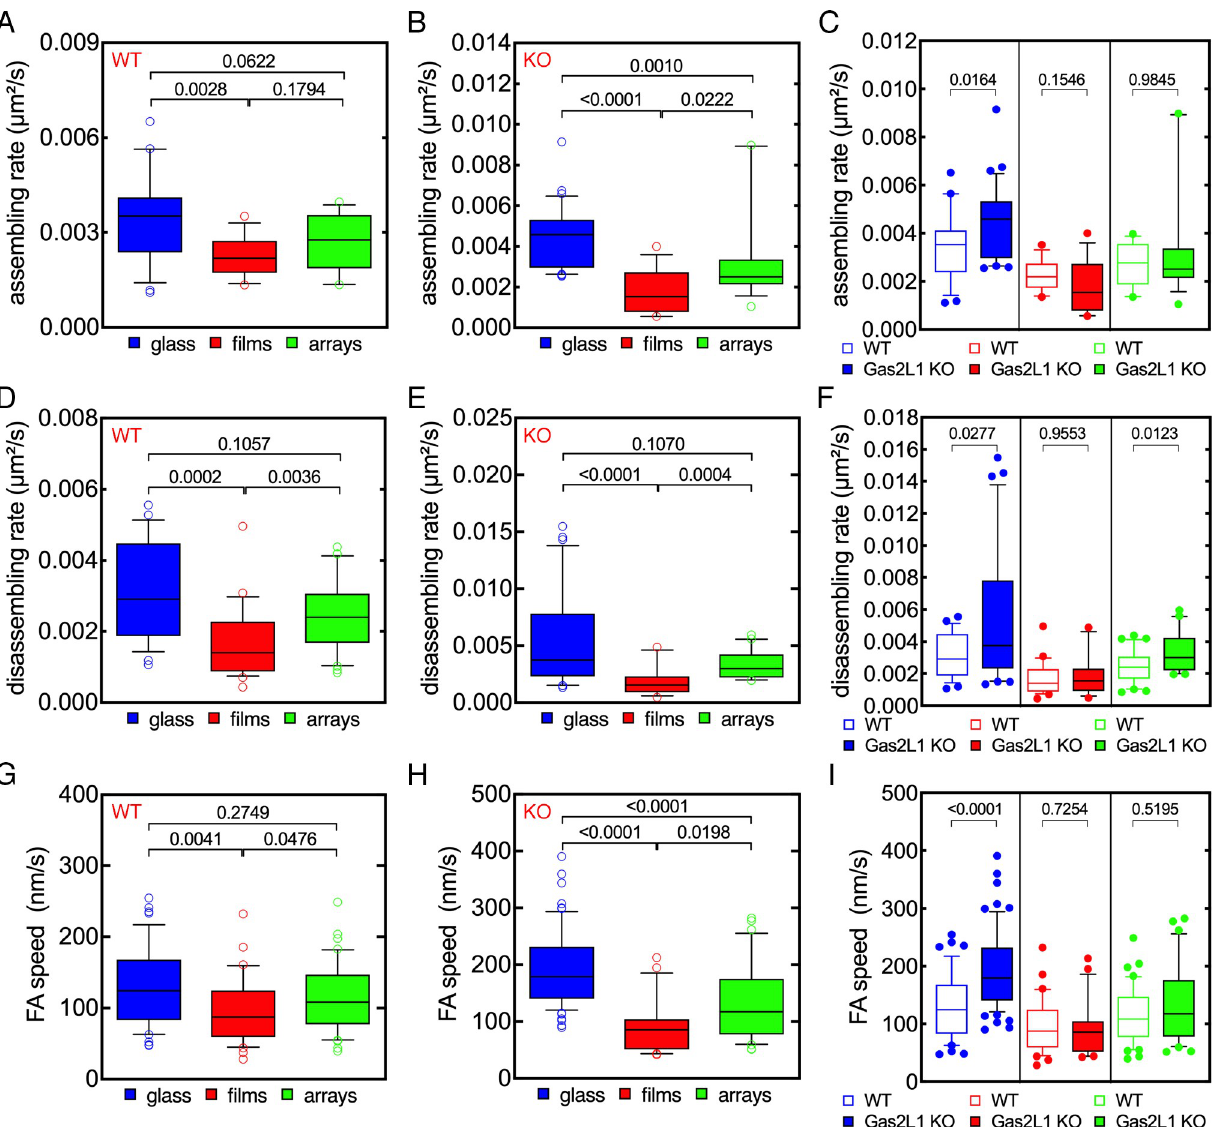
Fig 6. Impact of microgels on focal adhesion dynamics in wild-type and Gas2L1 KO Sertoli cells. (A-C) Control and Gas2L1 KO cells show similar FA assembly rates on microgel films and arrays. In both control (A) and Gas2L1 KO (B) cells, FA assembly rate is higher in cells seeded on to glass and lower in cells on microgel films (A, B). Pairwise comparisons show a higher focal adhesion assembly rate in cells seeded on to glass substrates. Notably, this difference is abolished when cells are seeded on to microgel films or arrays (C). (D-F) Control and Gas2L1 KO cells show similar focal adhesion disassembly rates on microgel films, but not on glass and microgel arrays. Both control (D) and Gas2L1 KO (E) cells are characterized by significantly lower levels of disassembly rates when seeded on to microgel films compared to glass and microgel arrays substrates (D, E). Pairwise analysis shows that the higher focal adhesion disassembly rate normally observed in Gas2L1 KO cells is reduced when cells are seeded on to microgel films (F). (G-I) Control and Gas2L1 KO cells show similar FA speeds on microgel films and arrays. Both control (G) and Gas2L1 KO (H) cells show the highest and lowest FA speeds on glass and microgel films, respectively (D, H). Interestingly, pairwise analysis shows that FA speed in Gas2L1 KO cells is reduced to levels comparable to those in control cells when cells are seeded on to microgel films or arrays (I). Color code for C, F and I. Blue: Glass; red: Films; green: Arrays. Numbers indicate p values. ns: Not